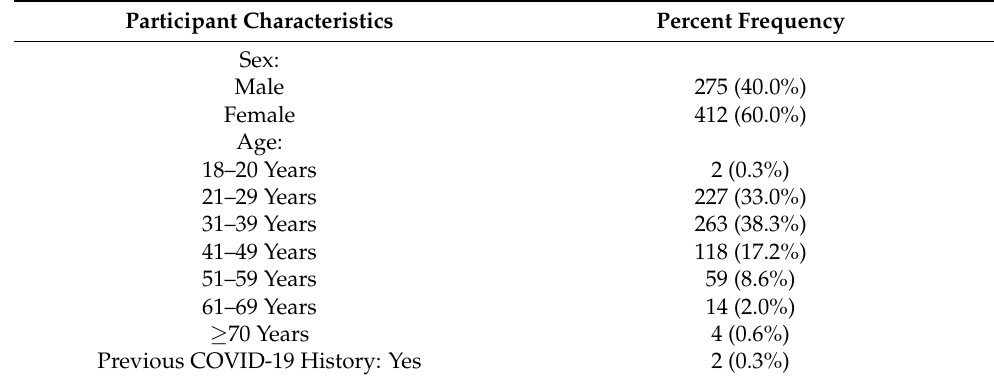
Table 1. Demographic characteristics and COVID-19 history of the study population.